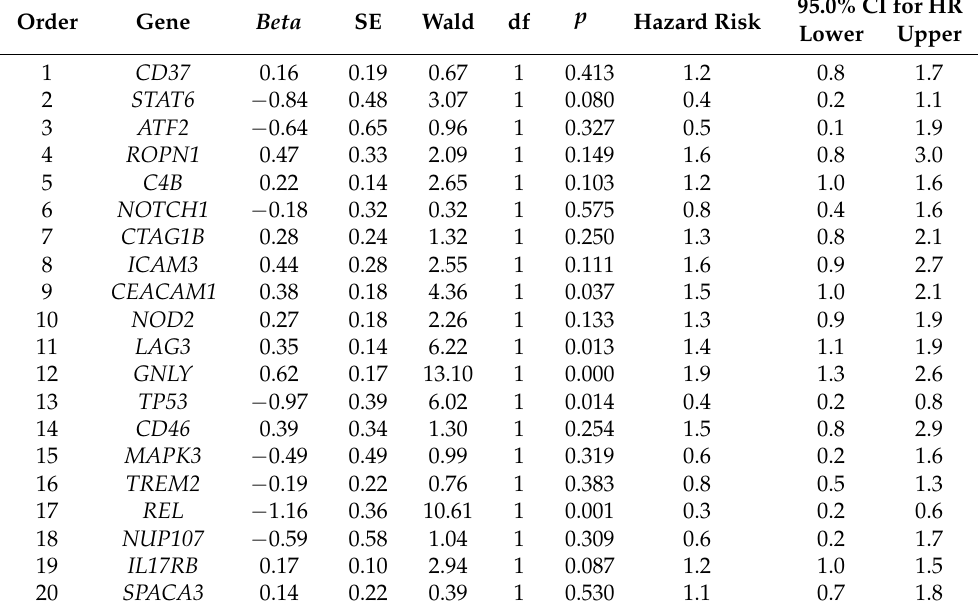
Table A2. Correlations between the top 20 genes of the multilayer perceptron and the molecular subtypes GCB vs. ABC+Unspecified (univariate